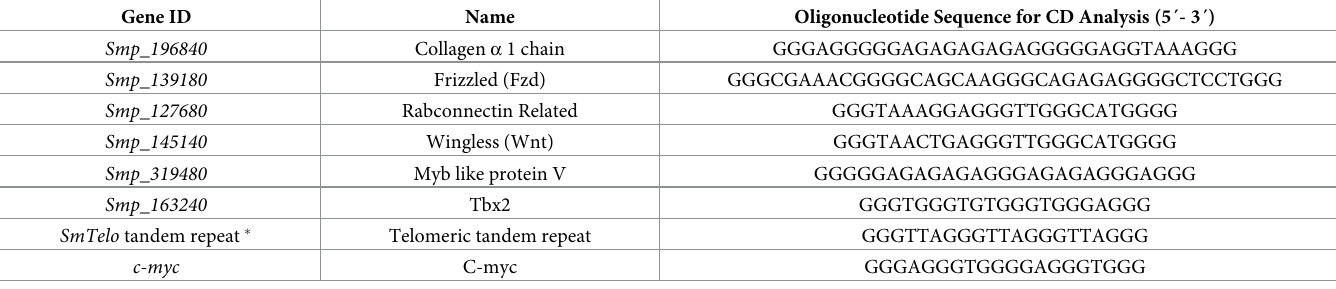
Table 1. Genomic identifiers and oligonucleotide sequences used in CD spectroscopy. Gene